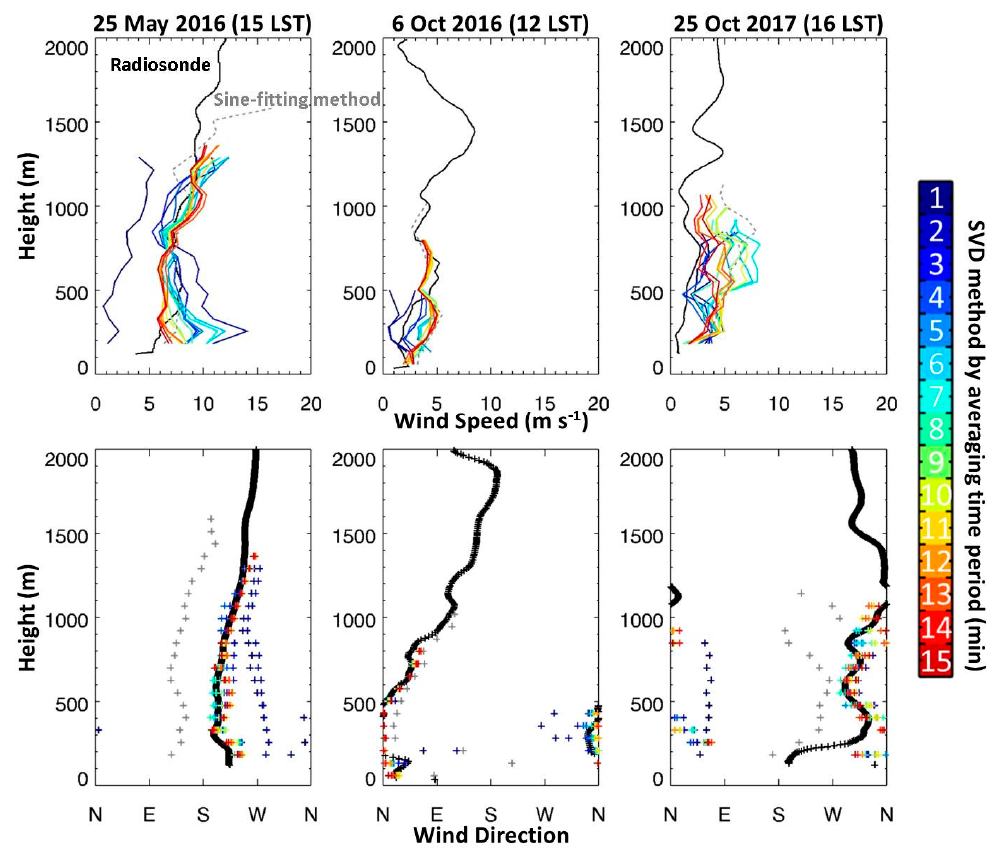
Figure 2. Examples of 15-min-averaged wind profiles using the sine-fitting method and singular value decomposition (SVD) method and radiosonde soundings. The colors indicate profiles retrieved from velocity–azimuth display (VAD) scans of different averaging time periods. LST stands for local standard time.